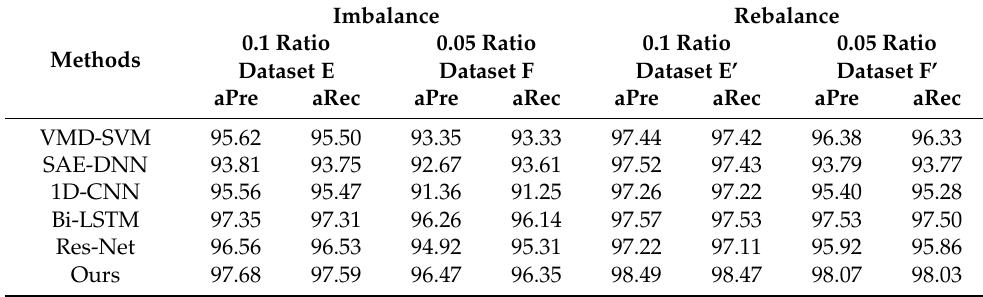
Table 9. The average precision and recall (%) of baselines and our proposed method for Case 2.